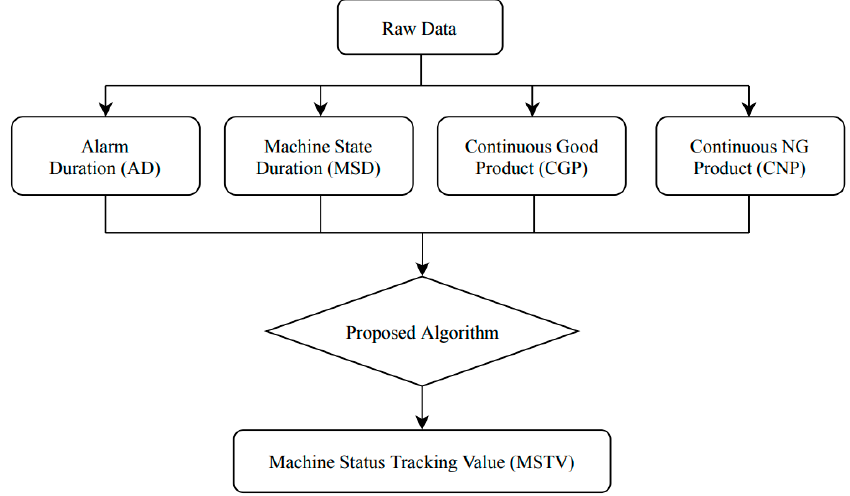
Figure 6. Architecture of proposed feature extraction .